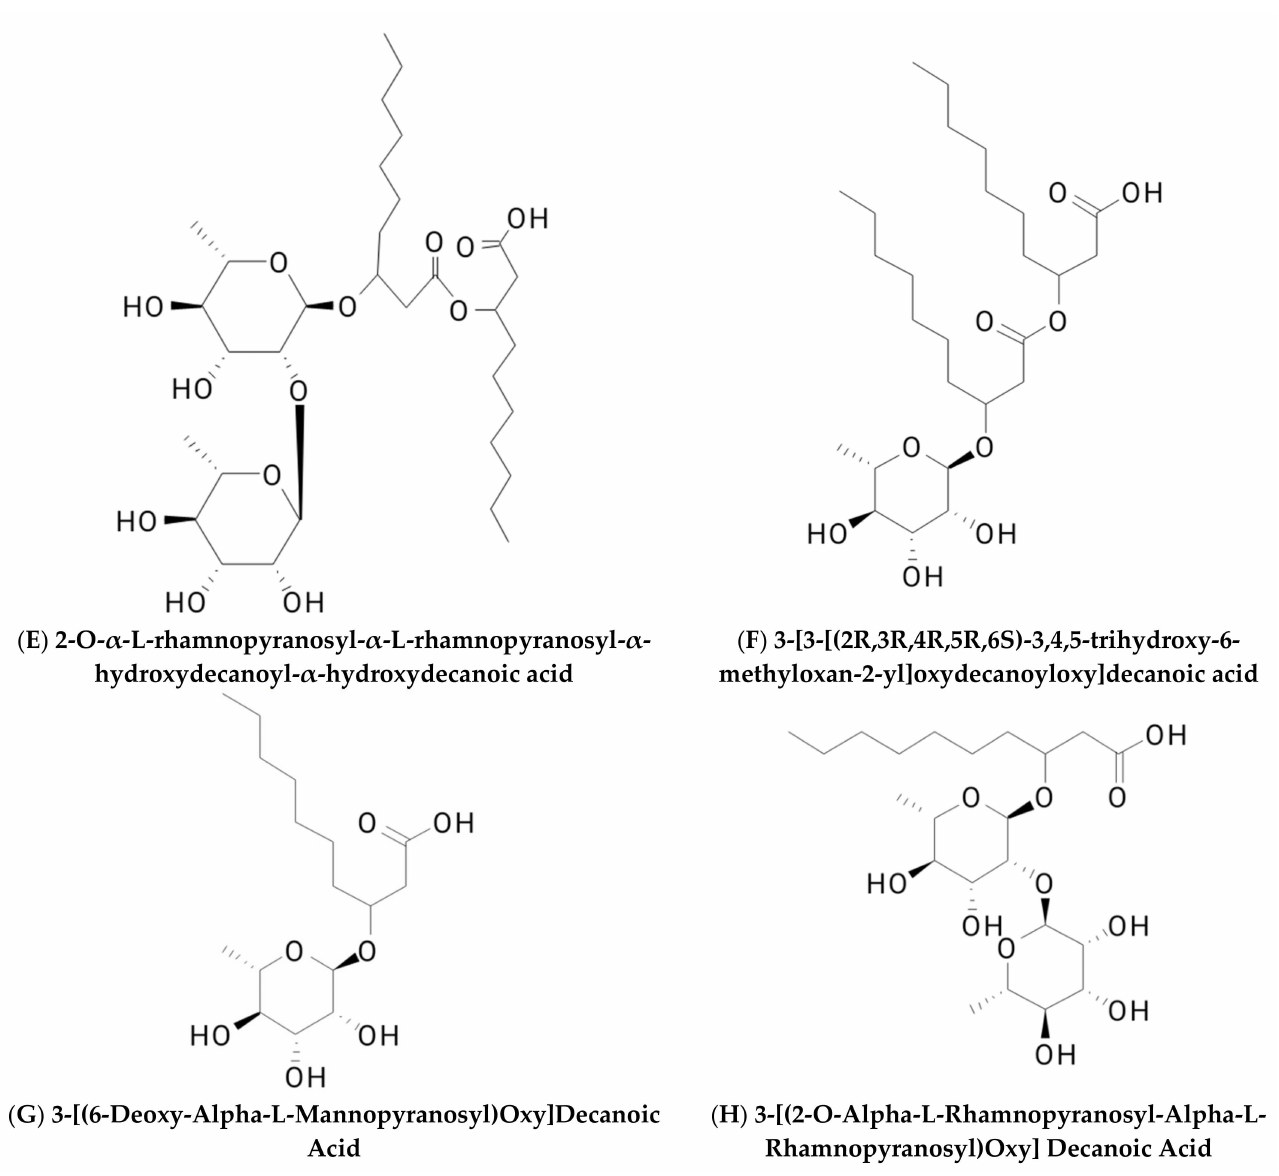
Figure 1. ( A – H ) The structures of